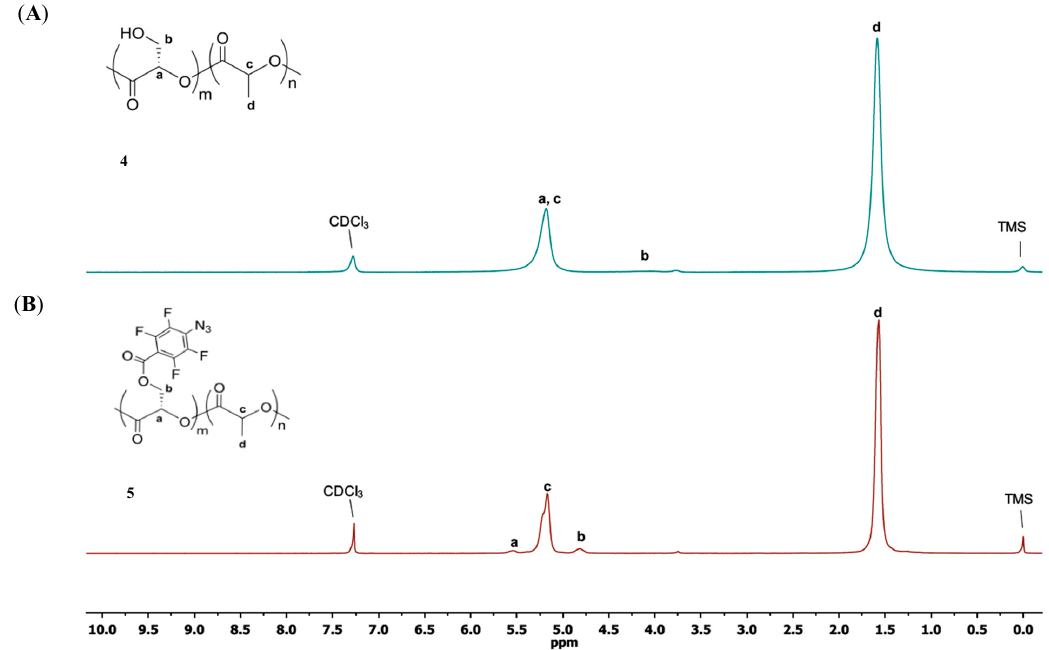
1 H-NMR spectra of copolymers 4 ( A ) and 5 ( B ) in CDCl Figure 1. 1 H ‐ NMR spectra of copolymers 4 ( A ) and 5 ( B ) in CDCl 3 . Figure 1. Figure 1. 1 H ‐ NMR spectra of copolymers 4 ( A ) and 5 ( B ) in CDCl 3 .